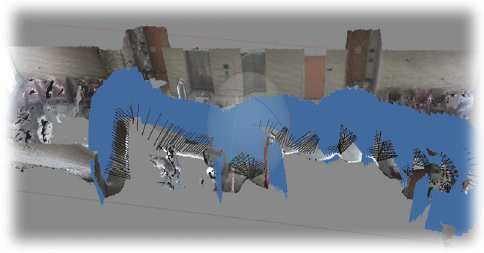
Figure 8: Localization by